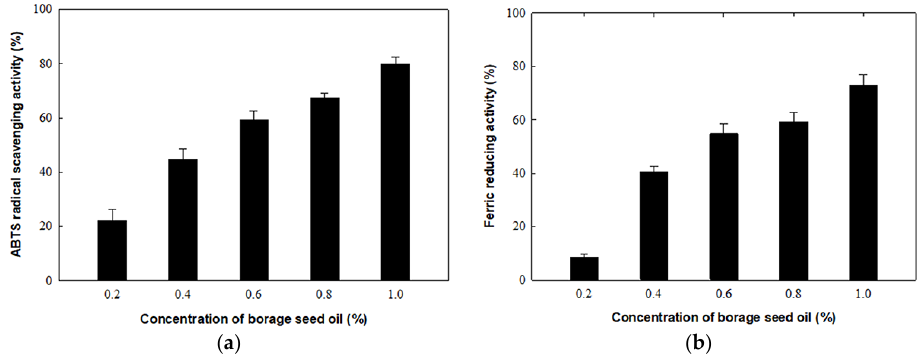
Figure 1. Antioxidant activities of the BMS films containing BO: ( a ) ABTS radical scavenging activity; ( b ) Ferric reducing activity.